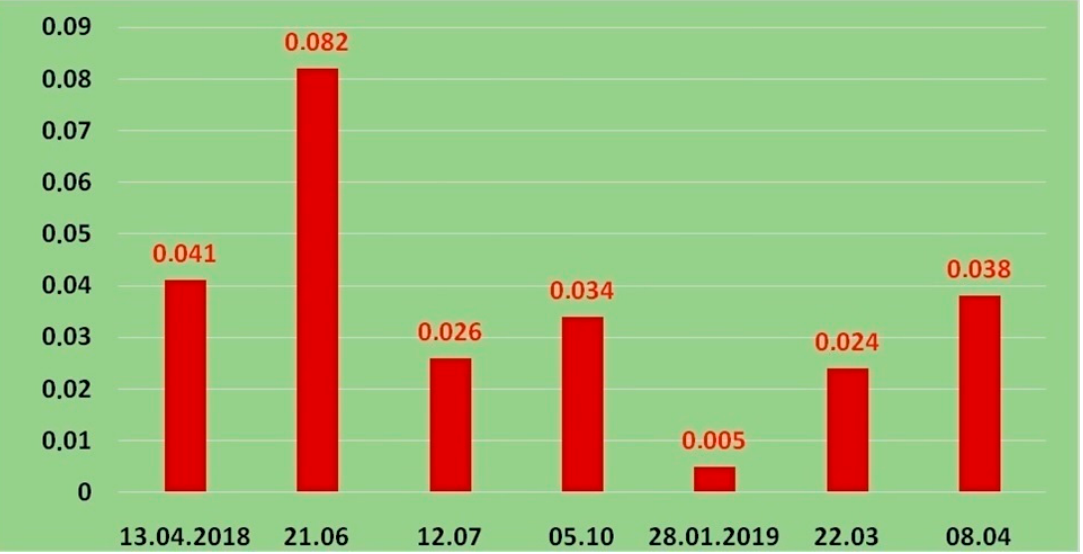
Figure 4. Species biomass diatoms in the Donuzlav Gulf of the Black Sea (2018–2019).